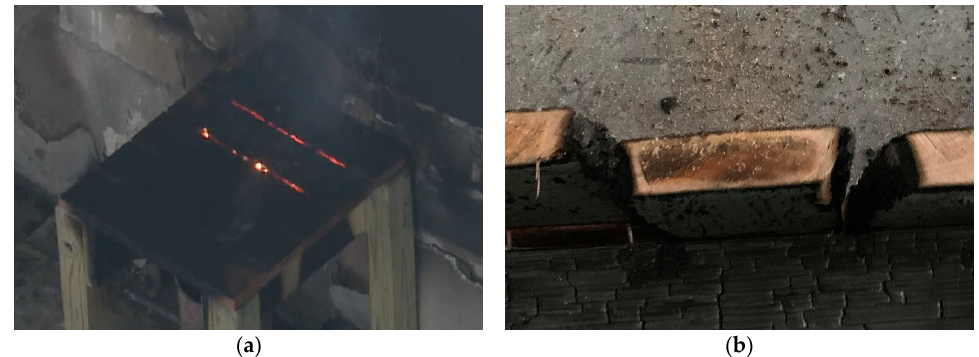
Figure 13. Replicating the current test method. ( a ) Fire intensity after 15 min (12 min after shutting off the gas burner). ( b ) Cross-section of the burned deck.